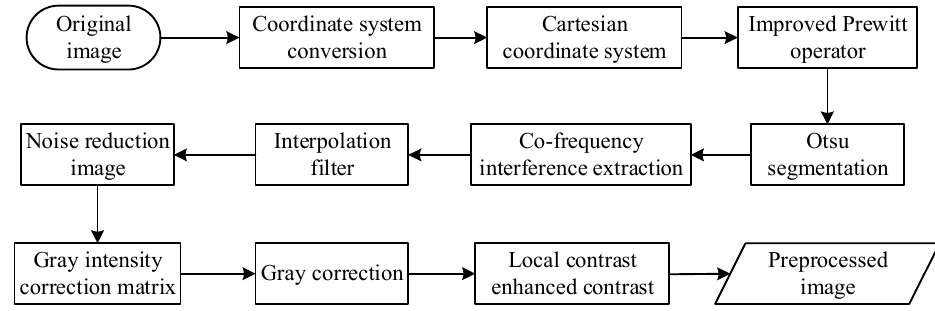
Figure 3. The data preprocessing scheme.